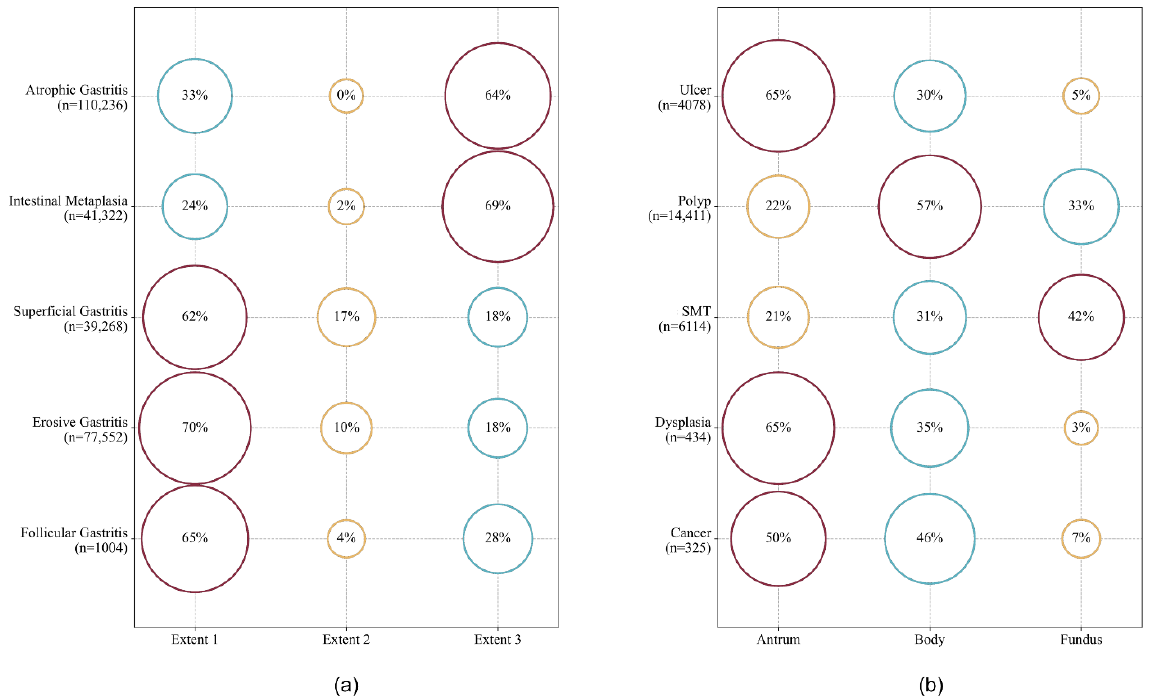
Figure 4. Extents and locations of gastritis ( a ) and other gastric diseases ( b ), respectively, between 2010 and 2019 ( n = 248,966). The sum of percentages of each disease may be lower or more than 100% due to the reports with unspecified locations and gastric disease at multiple locations in the stomach, respectively. Dysplasia includes tubular adenoma with low and high-grade dysplasia. Cancer includes carcinoma, neuroendocrine tumor, and lymphoma with mucosa-associated lymphoid tissue. Extent 1: antrum only; Extent 2: body/fundus only; Extent 3: antrum and body/fundus; SMT: submucosal tumor.